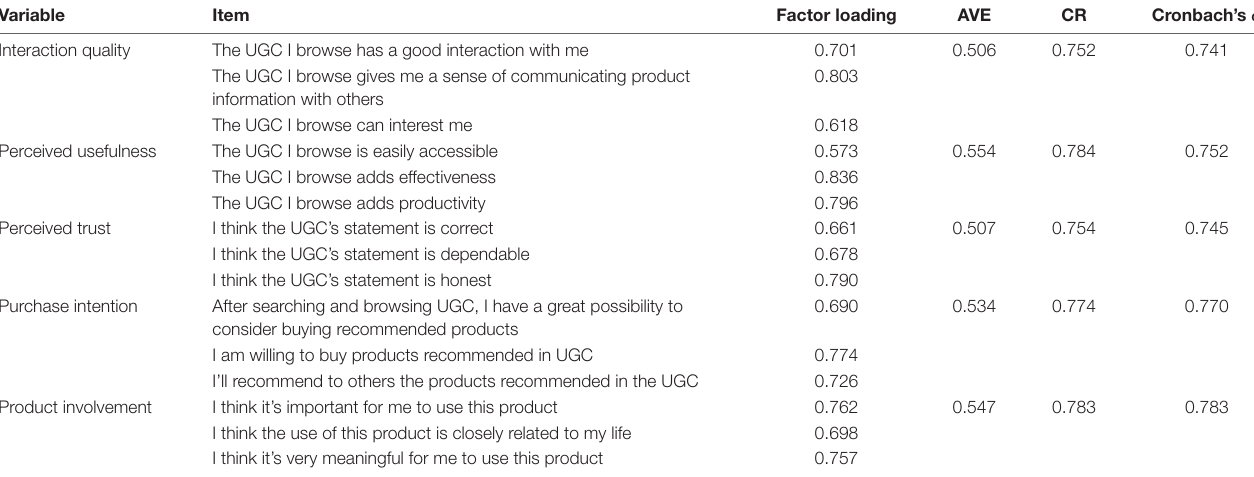
TABLE 1 | Constructs, scale items and descriptive